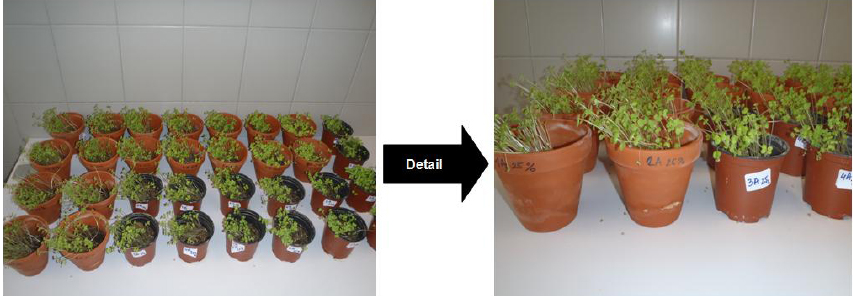
Figure 3. Samples of white